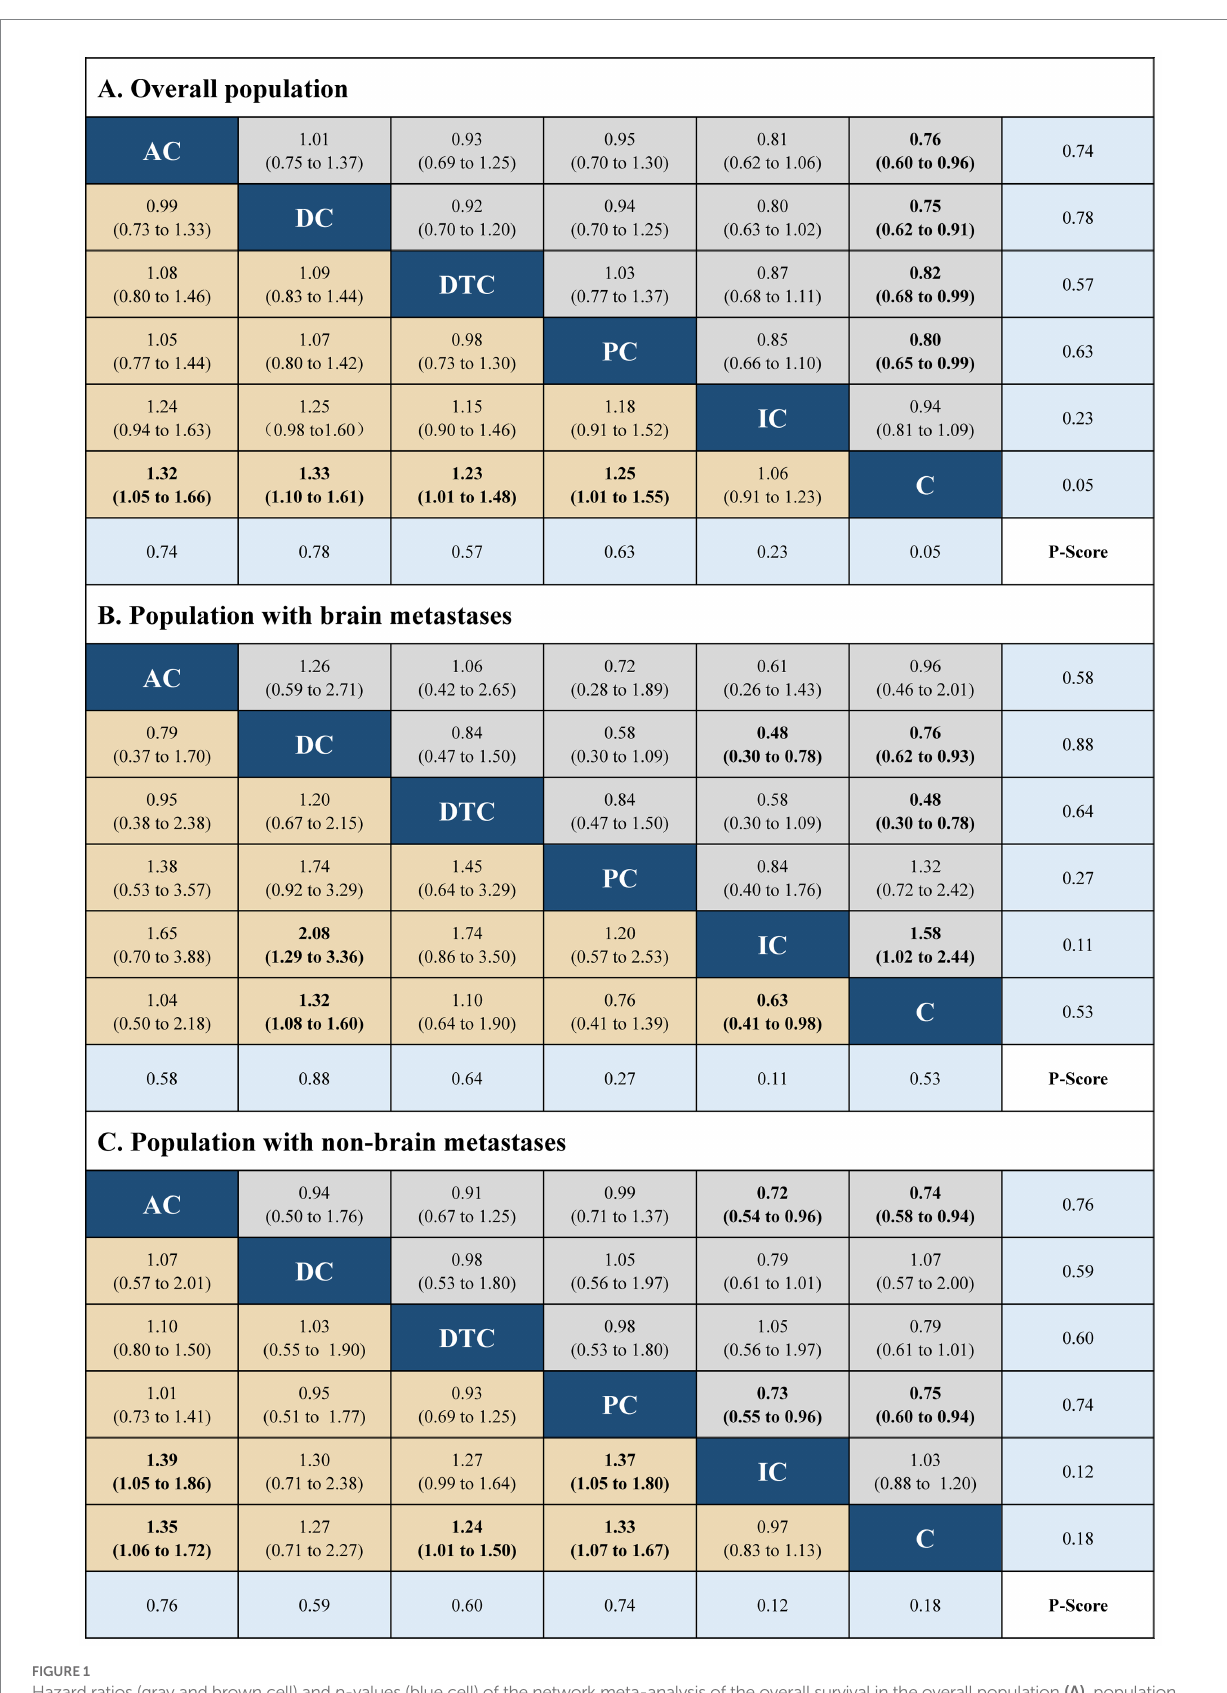
FIGURE 1 Hazard ratios (gray and brown cell) and p -values (blue cell) of the network meta-analysis of the overall survival in the overall population (A) , population with brain metastases (B) , and population with non-brain metastases (C) . AC, atezolizumab plus chemotherapy; DC, durvaluma plus chemotherapy; DTC, durvalumab with tremelimumab plus chemotherapy; PC, pembrolizumab plus chemotherapy; IC, ipilimumab plus chemotherapy; C,